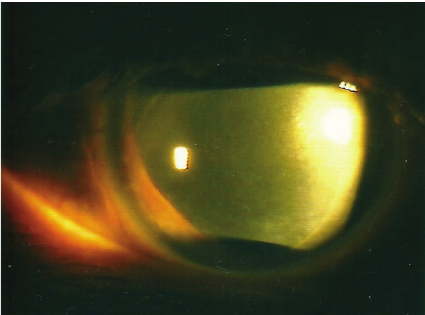
Figure 5: Slightly inferiorly displaced EK button and clear recipient cornea.